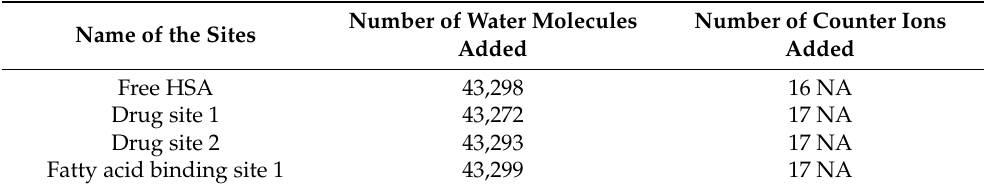
Table 9. Number of added water molecules, counter ions in the molecular dynamics simulation of three sites of human serum albumin with indomethacin (source: Gromacs). Number of Water Molecules Number of Counter Ions Name of the Sites Added Added Free HSA 43,298 16 NA Drug site 1 43,272 17 NA Drug site 2 43,293 17 NA Fatty acid binding site 1 43,299 17